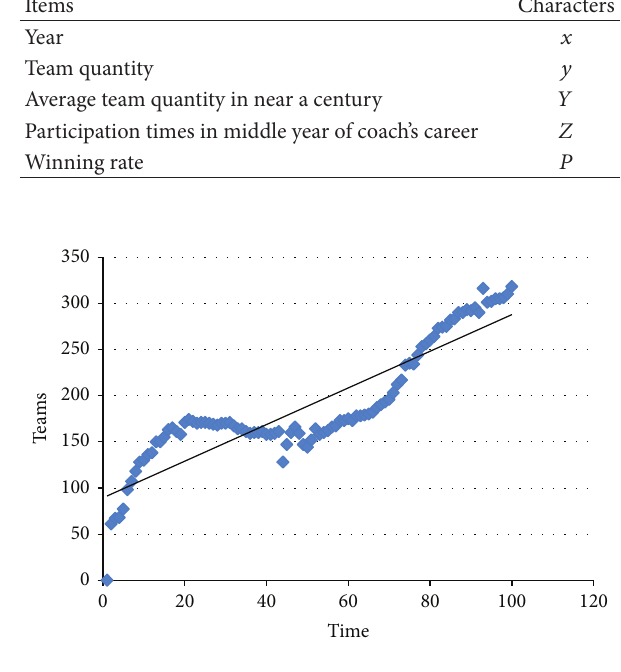
Figure 2: Curve of year and teams